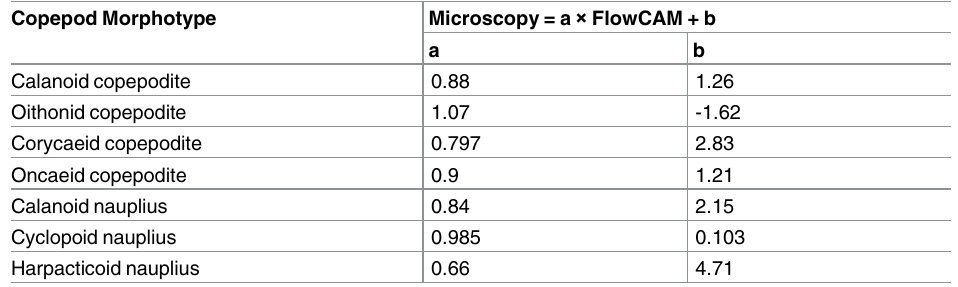
Table 1. Regression coefficients for biovolume data transformation (from FlowCAM data to Micros- copy data at log scale) for 7 dominant copepod morphotypes using a linear regression model. Copepod